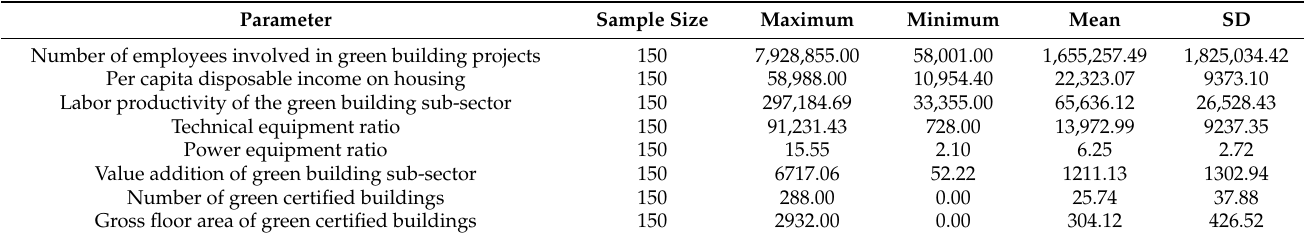
Table 2. Descriptive statistics of input–output parameters